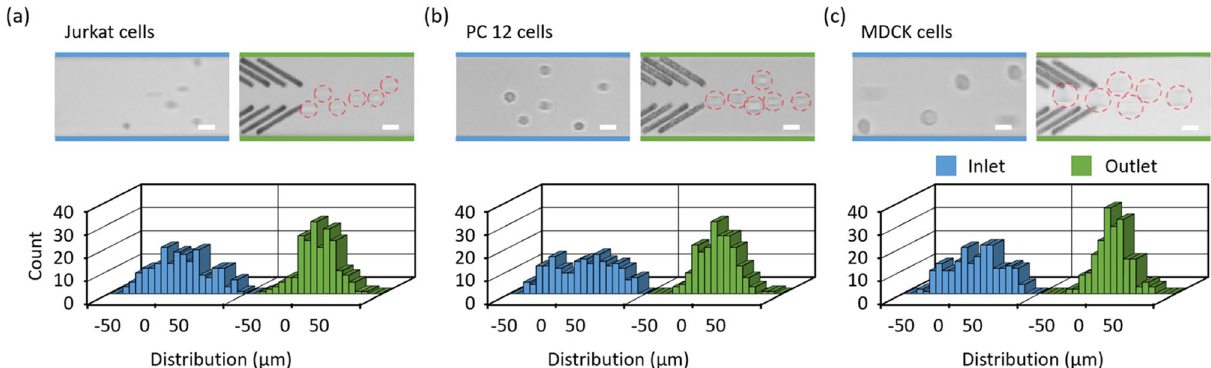
Figure 7. Focusing of live cells by the microfluidic device with fs laser patterned arrays of open v-shaped microstructures. The lateral positions of ( a ) Jurkat cells, ( b ) PC 12 cells and ( c ) MDCK cells at the inlet and outlet are recorded and compared, when the flow rate is 180 nL/min. Superimposed experimental images of cell distribution are presented. Red dotted circles denote cells. Scale bar is 20 µm. 200 cells are measured for each